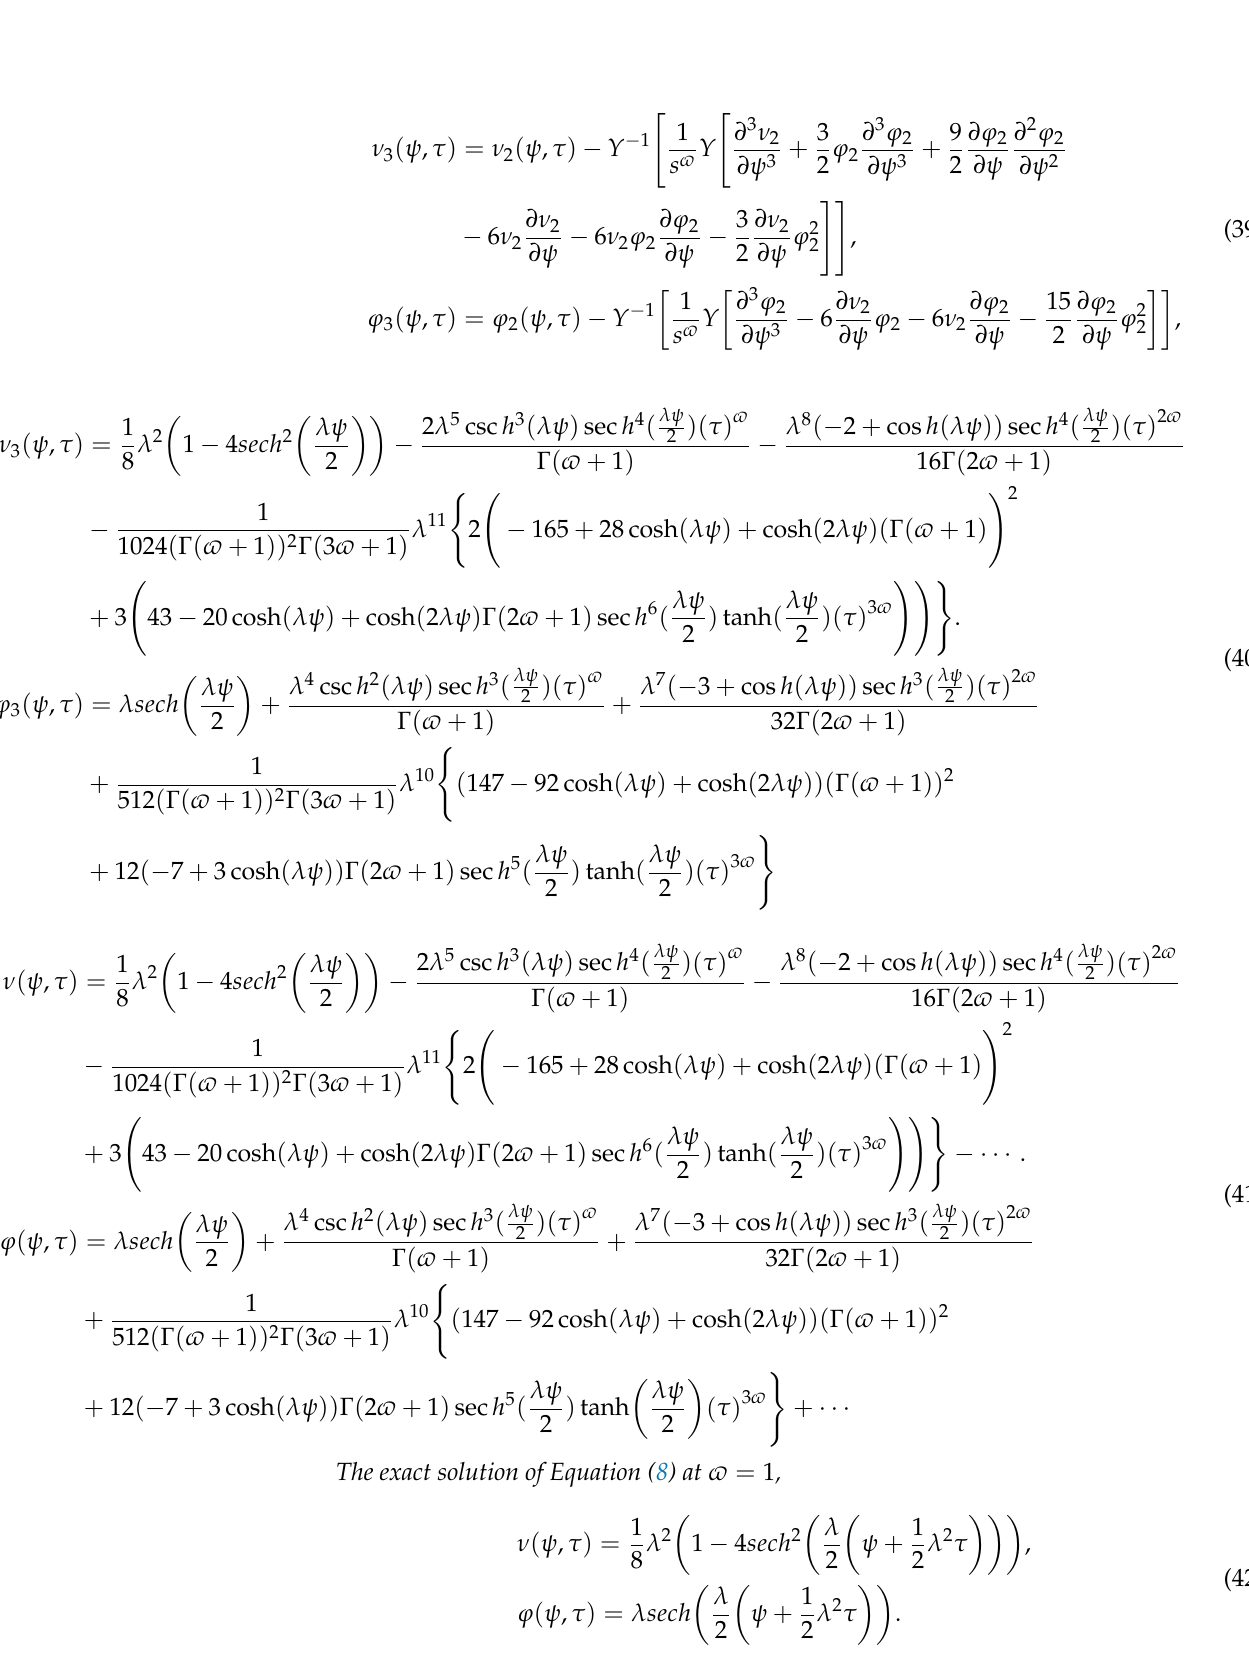
Figure 1, exact and analytical solution of ν ( ψ , τ ) at (cid:118) = 1 and 0.8 and Figure 2, analytical solutions of ν ( ψ , τ ) at (cid:118) = 0.6 and 0.4 . Figure 3, the different fractional-order of (cid:118) of ν ( ψ , τ ) . In Tables 1 and 2 the different fractional-order of ℘ of ν ( ψ , τ ) and ϕ ( ψ , τ ) of Problem